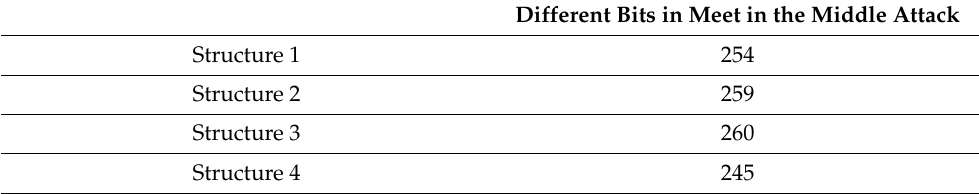
Table 15. Different bits in meet-in-the-middle